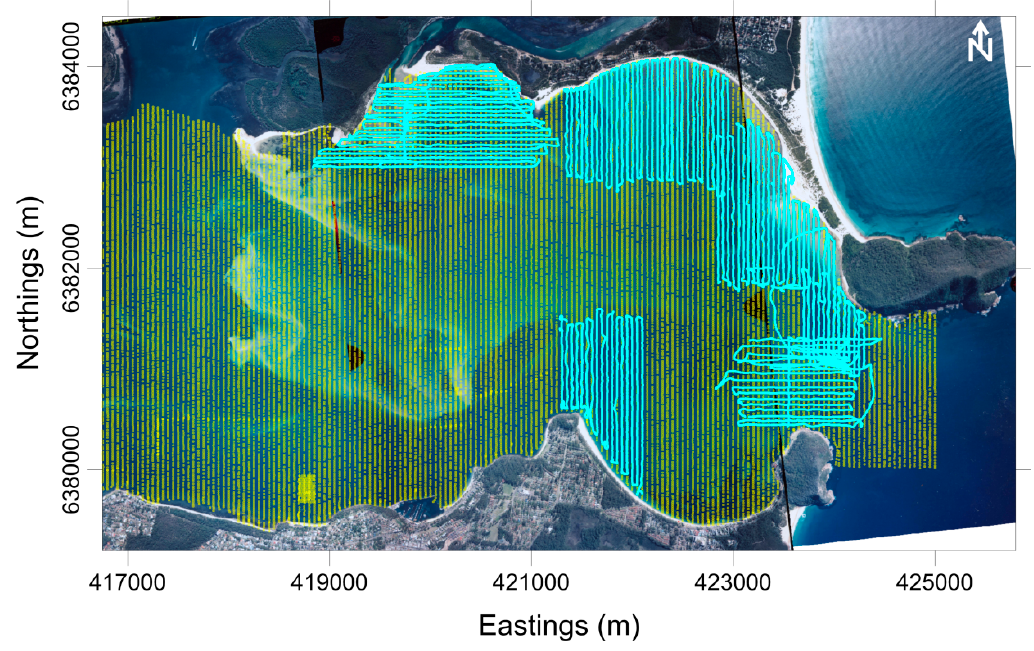
Figure 2. Bathymetric surveys. The 2007 survey is in yellow and the 2010 survey is in blue. (Grid coordinates are in MGA Zone 56.)